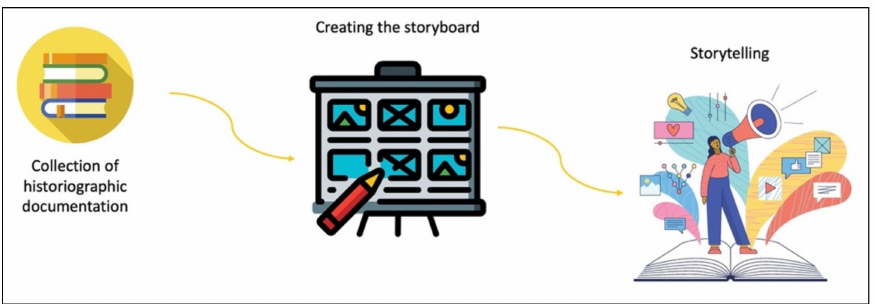
Figure 2. The preliminary phase leading to the definition of the